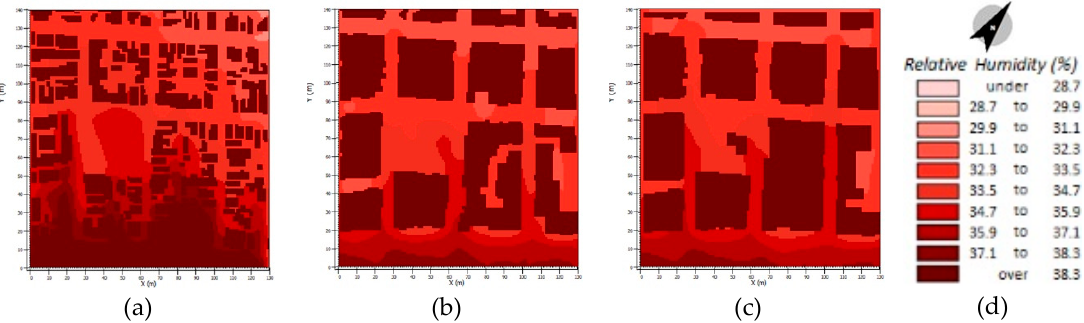
Figure 6. Humidity (Hu) results for January 2018 (average), 8 p.m.: ( a ) Sprawl Morphology (urban form data: 1930); ( b ) Medium Morphology (urban form data: 1950); ( c ) Density Morphology (urban form data: 2018); and ( d ) Color scale.